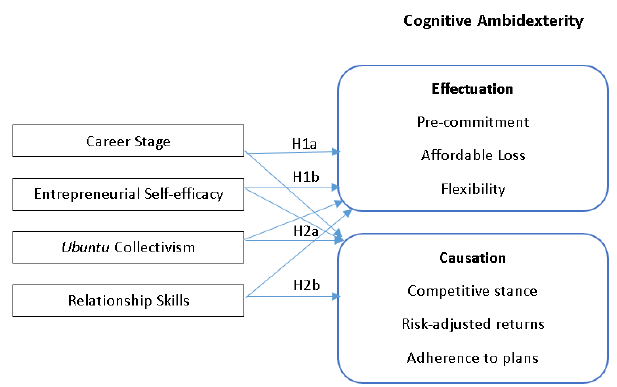
Figure 1: Model of hypothesized relationships Research design and